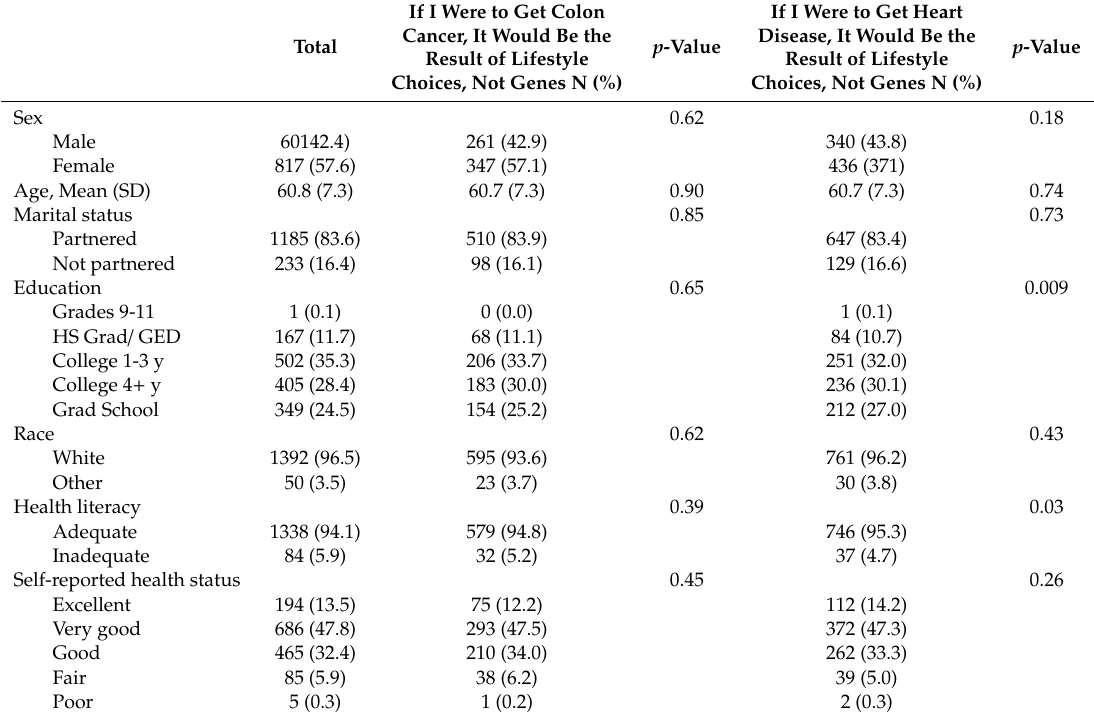
Table 4. Participant emphasis on negative genomic screening results compared to lifestyle choices in primary attribution of the cause of hypothetical future disease.